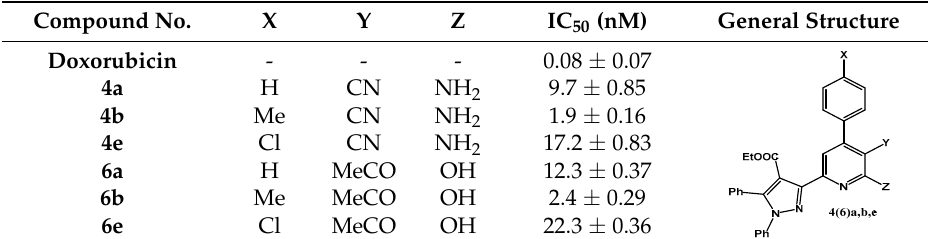
Table 1. IC 50 values of tested compounds 4 and 6 ± standard deviation against HEPG2-1. Compound No.